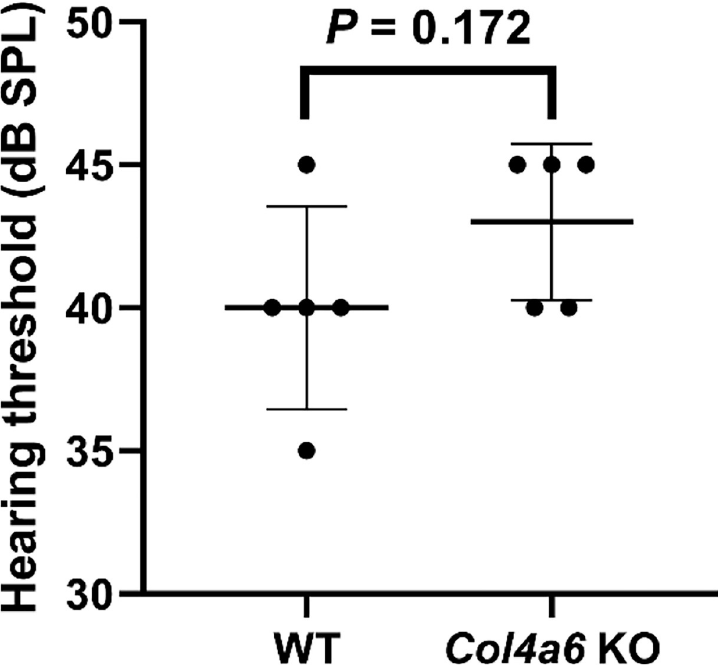
Fig 4. Hearing threshold assessed by click-evoked auditory brainstem responses in WT and Col4a6 KO mice. No significant difference observed between WT mice (mean 40 ± 3.5 dB SPL, n = 5) and Col4a6 KO mice (mean 43 ± 2.7 dB SPL, n = 5). P = 0.172 by Student’s unpaired t -tests. The values are presented as mean ±